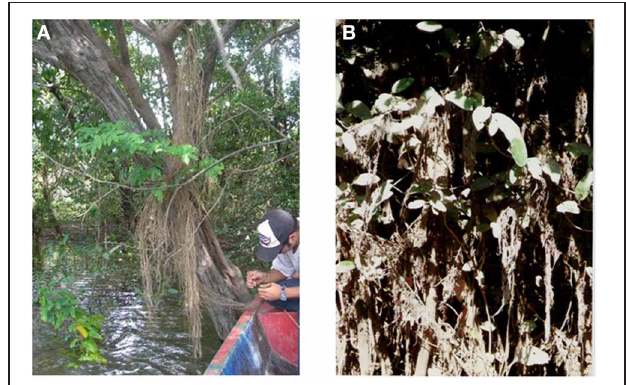
FIGURE 5 | Adventitious roots observed in October at falling-waters in trees of: (A) Campsiandra laurifolia and (B) Symmeria paniculata . Note in (B) the mud deposits on leaves from previous flood.